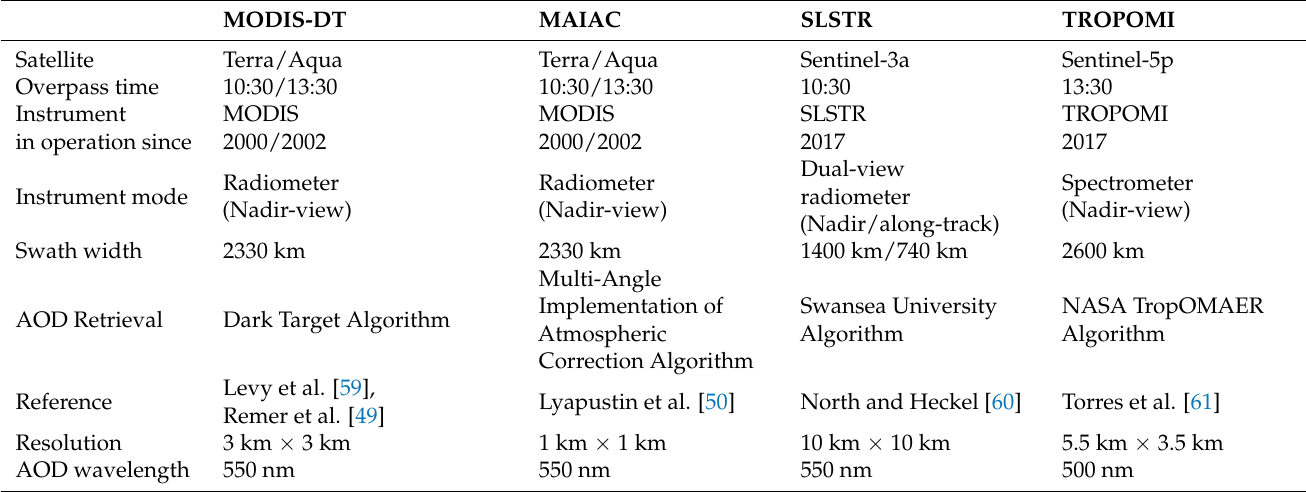
Table 1. Overview of the different AOD datasets with key references.